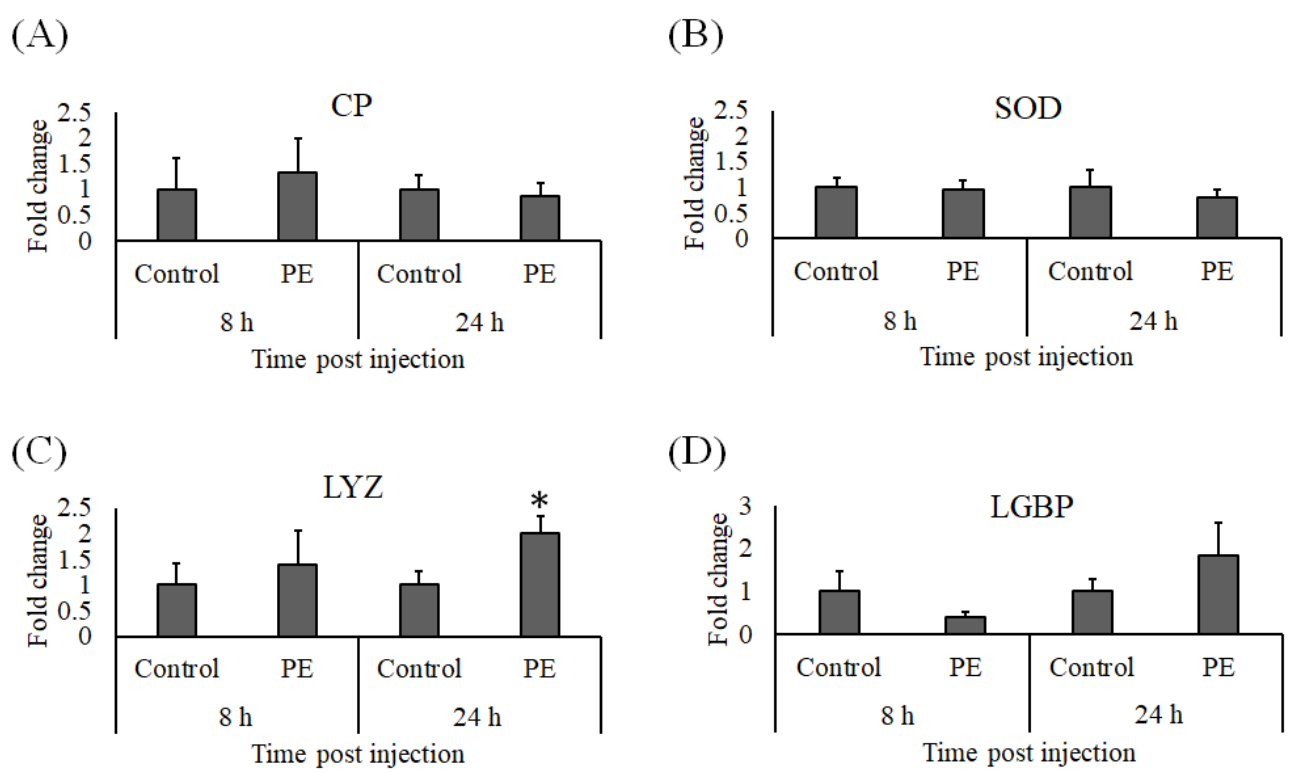
Figure 8. Gene expression of ( A ) CP , ( B ) SOD , ( C ) LYZ , and ( D ) LGBP in hemocytes from whiteleg shrimp ( Litopenaeus vannamei ) injected with 0.30 μ g of phycoerythrin (PE) per gram of whiteleg shrimp body weight or vehicle alone (control). After 8 and 24 h of stimulation, the relative expression levels of immune genes were normalized to the transcript level of EF1 α and presented as a fold change relative to the control group. Data are expressed as the mean ± standard error of the mean ( n = 5) and significant differences from the control group are denoted by asterisks ( p < 0.05 , paired sample t -test).